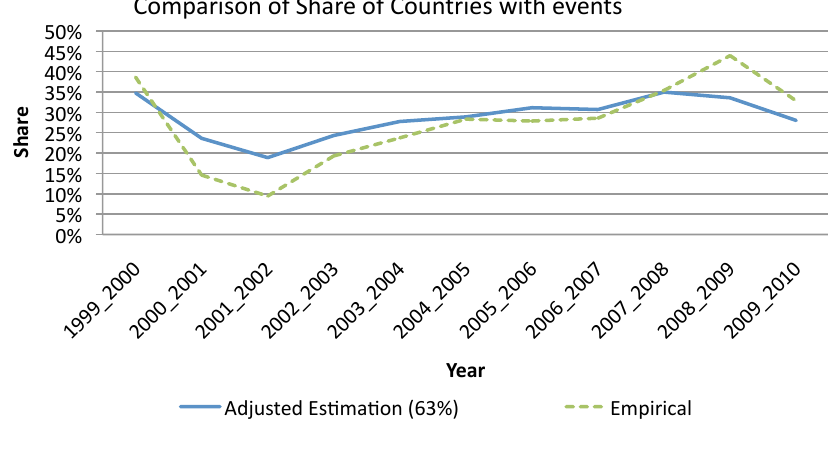
Figure 3: Comparison of share of countries in the